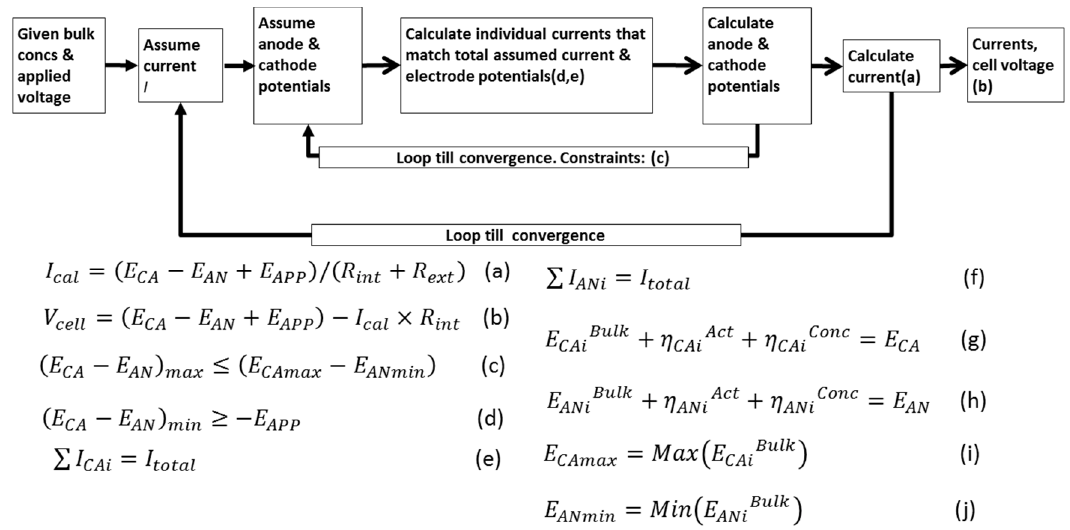
Figure 5. Electrical model structure and solution procedure in the integrated microbial electrochemical technology (MET) system allowing for multiple electrode reactions. More details presented in Figure